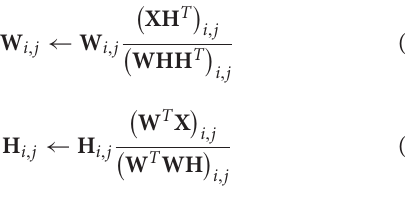
to extract the features of EEG, such as maximum